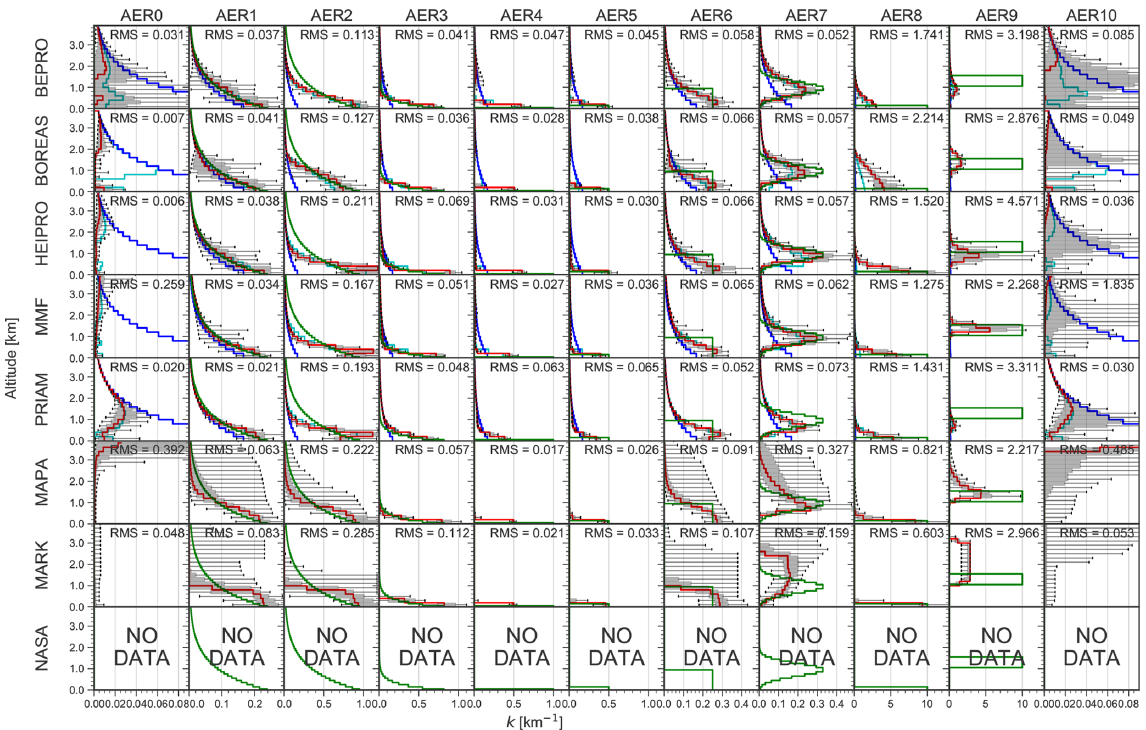
Figure 11. Comparison of retrieved (red solid line, version v1n) and true (green solid line) vertical profiles of aerosol extinction at 360nm for each aerosol scenario (columns) and algorithm (rows). The retrieved profiles are the medians for all SZA–RAA combinations. The (25%– 75%) and (5%–95%) percentiles are shown as grey areas and whiskers, respectively. The a priori profile is shown as the blue line (OEM algorithms